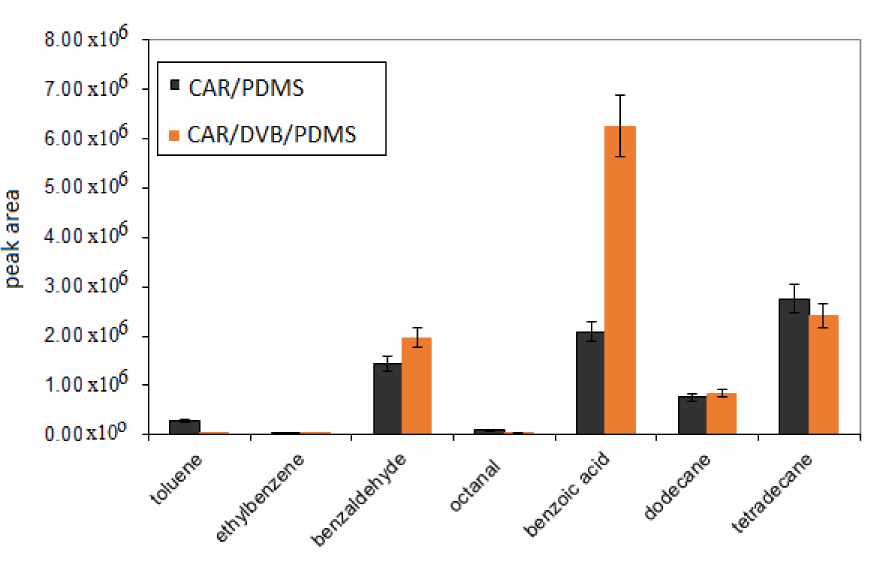
Figure 1. Instrumental response obtained extracting the selected compounds from the HS using the CAR/PDMS and CAR/DVB/PDMS fibers,